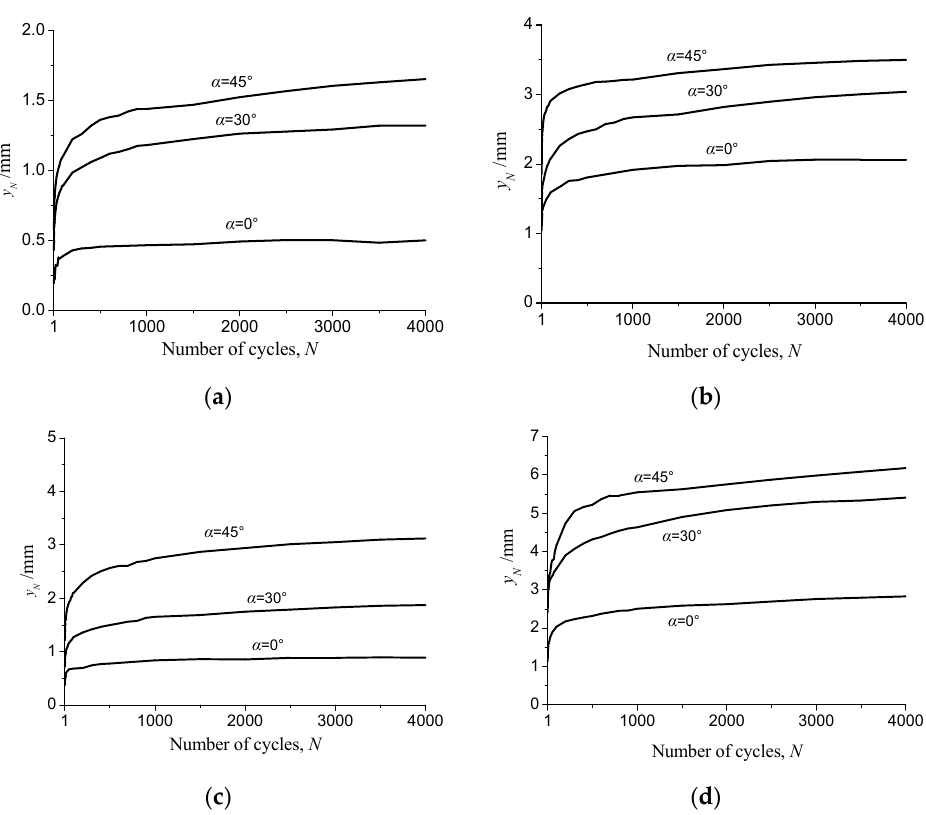
Figure 13. Cyclic test results of residual accumulated displacements. ( a ) η b = 0.4, s d = 0 ( b ) η b = 0.6, s d = 0 ( c ) η b = 0.4, s d = 1 D ( d ) η b = 0.6, s d = 1 D